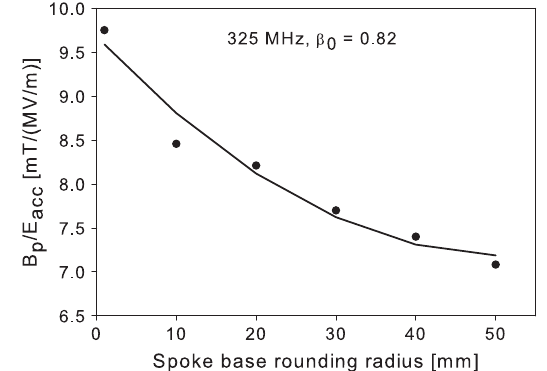
radius.FIG. 30. Dependence of the normalized electric field and RR s on the parameter